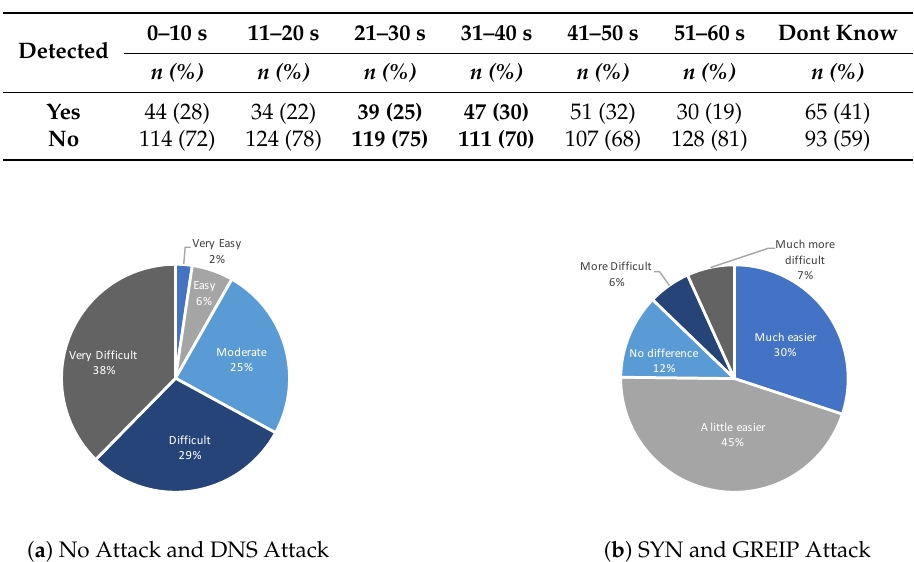
Table 5. Scenario four detection rate (greip attack).